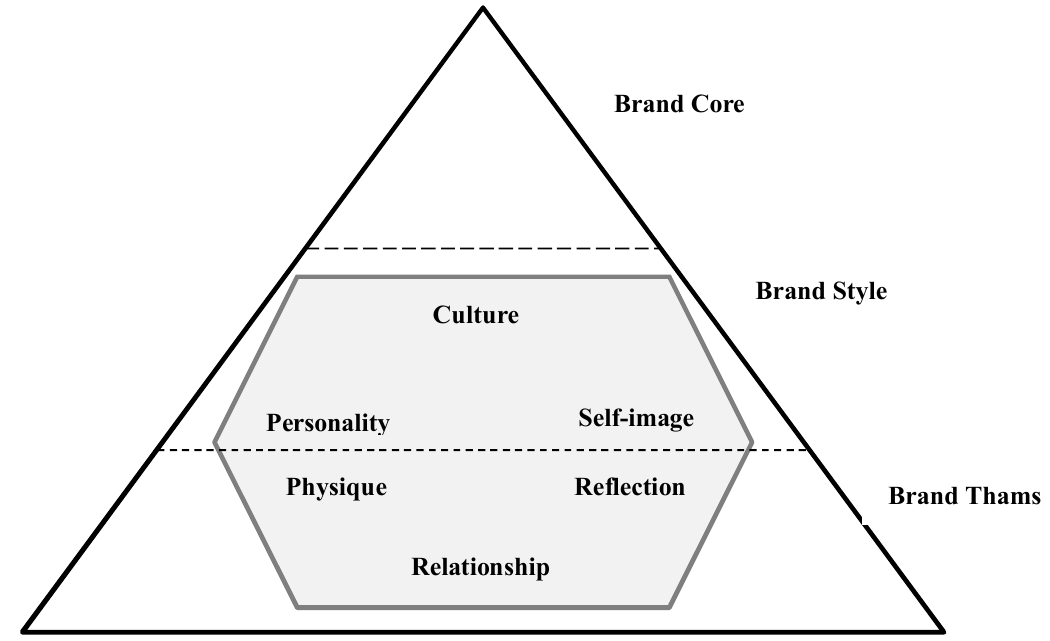
Fig. 1. The brand pyramid and the identity prism (Doyle ,